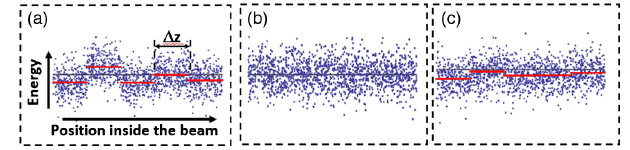
FIG. 1. An illustration of a stochastic cooling process: (a) a fragment of the beam longitudinal phase-space before correction showing exaggerated offsets of a central energy in beam slices, (b) the same fragment after correction of the offsets, and (c) the same fragment showing the appearance of newly emerged offsets after mixing of the beam particles.